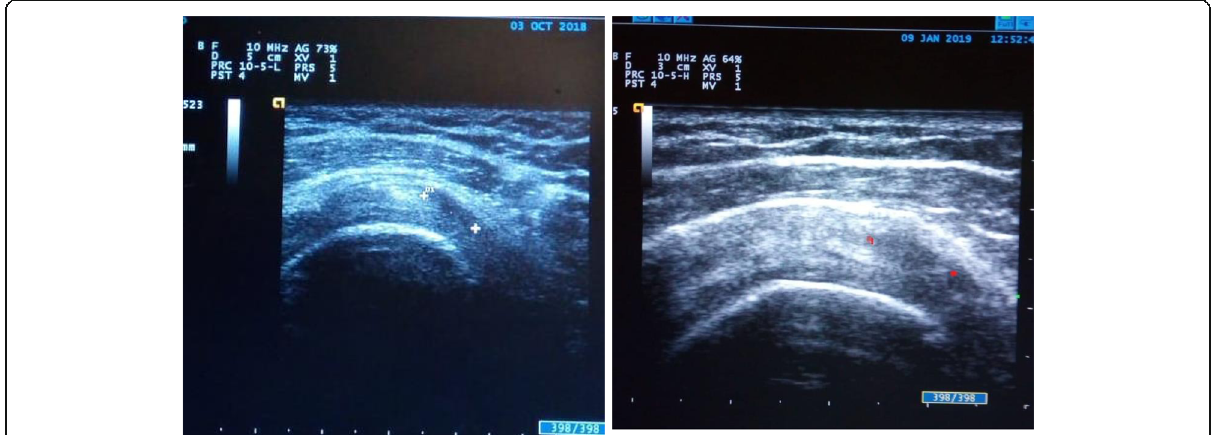
Fig. 2 US imaging for transverse axis US showing partial supraspinatus tear in left shoulder of a 57-year-old male patient a before PRP injection (tear size = 9.3 mm) and b 12 weeks post-injection (tear size = 9.1